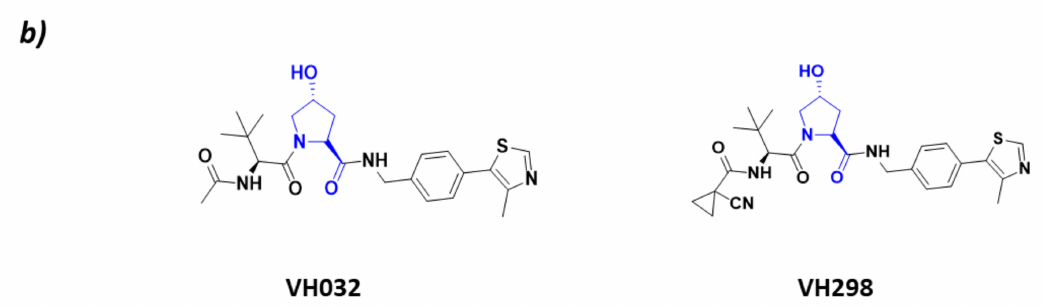
Figure 4. CRL2 VHL ( a ) Schematic representation of the assembly of the CRL2 VHL E3 ligase: ubiquitin (Ub) in purple, E2 ligase (E2) in dark blue, Ring Box Protein 1 (Rbx1) in yellow, Cullin-2 (Cul2) in magenta, adaptor protein Elongin B (EloB) in orange and Elongin C (EloC) in green, substrate recognition protein VHL (VHL) in light blue, and substrate protein in grey. Protein assembly I is the 3D representation of the system made up of Cul2, EloB, EloC, and a small α -helix of VHL as found in PDB code 5N4W. Protein assembly II is the 3D representation of the N -terminal end of Cul2 bound to EloB, EloC, and VHL, as found in PDB code 4WQO. ( b ) 2D representation of the structures of the main VHL:HIF-1 α inhibitors developed by Ciulli A. et al. [63,64]. The hydroxylated proline that mimics the activated HIF-1 α is represented in